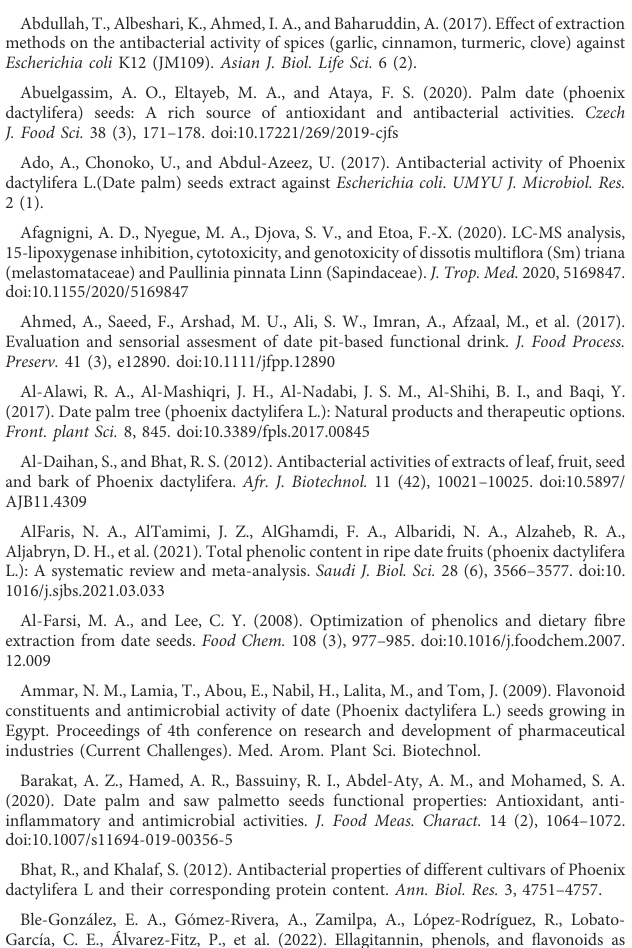
SUPPLEMENTARY FIGURE S1 Boxplot of pooled median ± range of total phenolic content (TPC) values reported in included studies (values in parentheses indicate number of studies by cultivar). SUPPLEMENTARY FIGURE S2 Boxplot of pooled median ± range of zone of inhibition (ZOI) results reported against S. aureus in included studies (values in parentheses indicate number of studies). *Gallic acid was isolated from the date seed extract and used for the test. SUPPLEMENTARY FIGURE S3 Boxplot of pooled median ± range of zone of inhibition (ZOI) results reported against E. coli in included studies (values in parentheses indicate number of